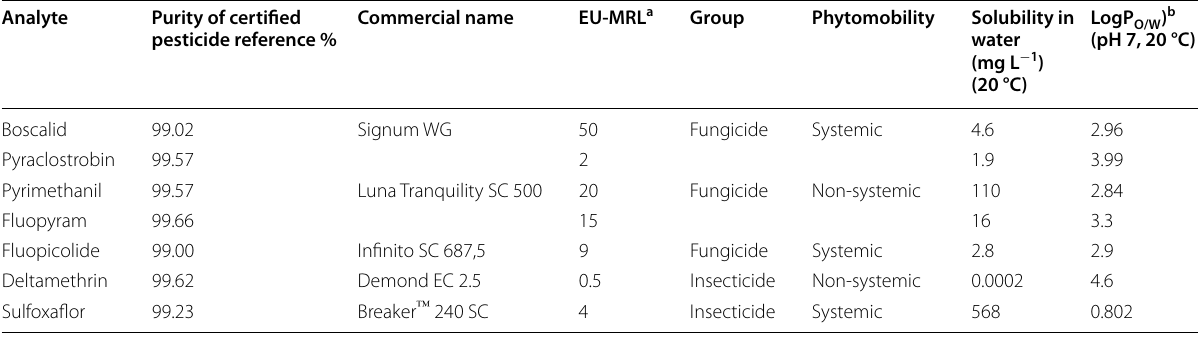
a EU-MRL: European Union-Maximum Residue Limit (µg kg − 1 ) for lettuce [16] b Octanol-water partition coefficient (LogP O/W ) of pesticides represents the ratio of the solubility of a compound in octanol (a non-polar solvent) to its water solubility (a polar solvent)” [27]